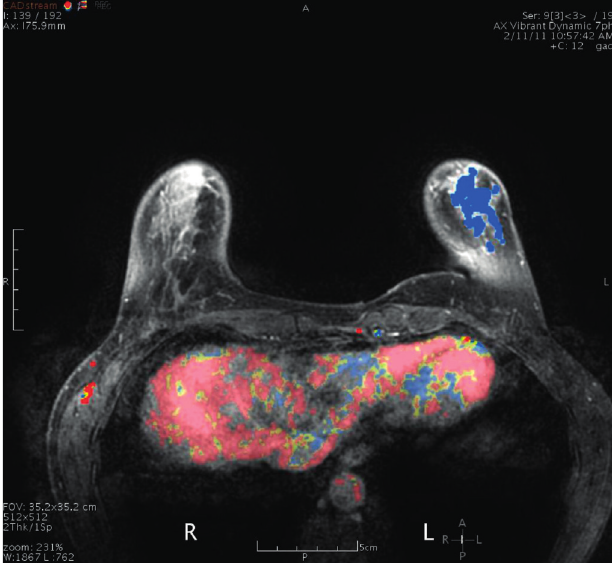
Fig. 2. The MRI over-estimated the size of the lesions. The patient had appropriate